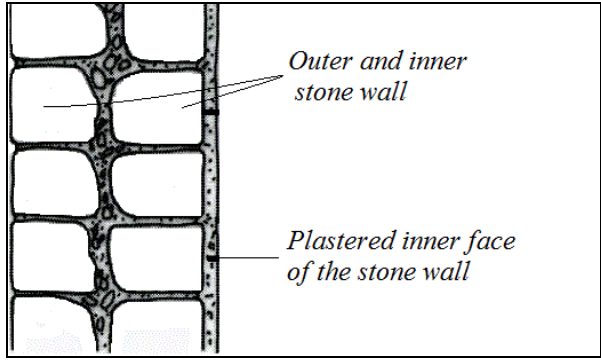
Figure 13. The corners of the house were constructed using extended blocks. Figure 13. Stone wall with two sides.